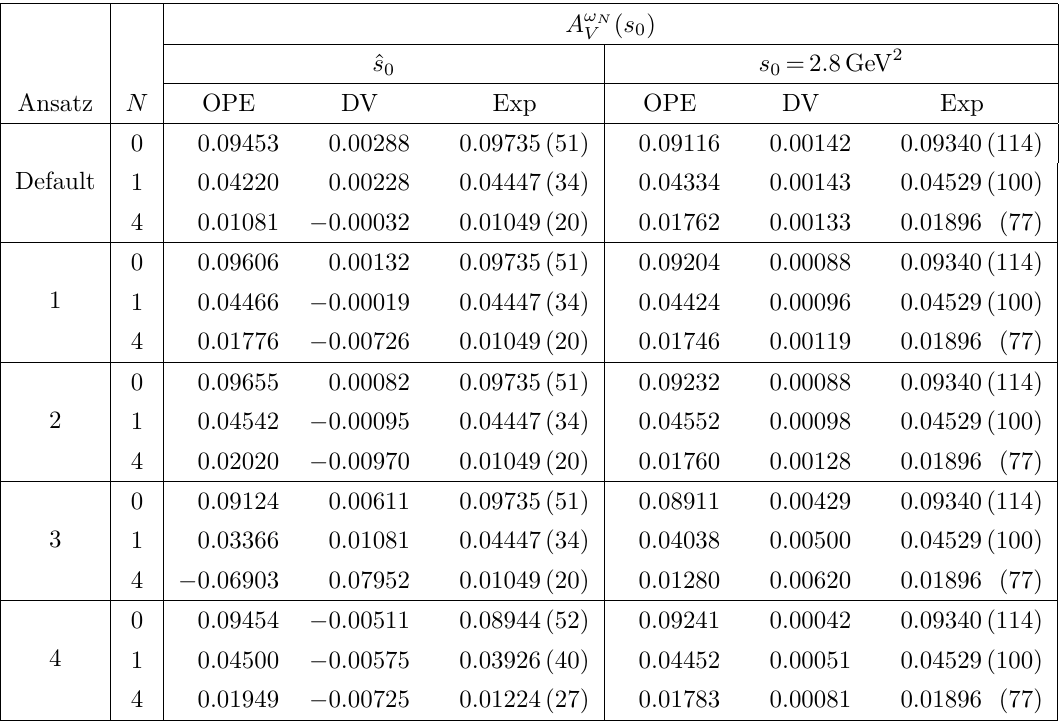
Table 10 . Separate values of the OPE and DV contributions to the moments of the vector dis- tribution A ω N ( s ) , obtained with the different ansatz variations, together with their experimental 0 V values, for the relevant weights ω ( x ) = x N N